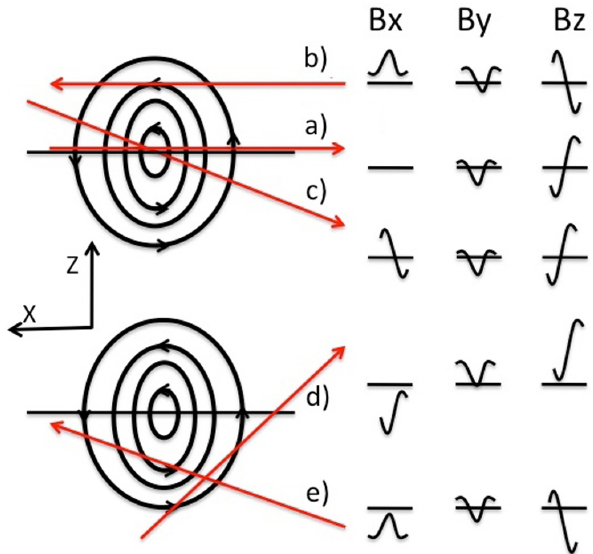
Fig. 1. Sketches of flux ropes observed in the XZ plane (black circu- lar lines and the current sheet (black line) with examples of trajec- tories across a spacecraft (red lines). The corresponding magnetic field signatures are found to the right of the figure. The core field is assumed to be negative, using our coordinate